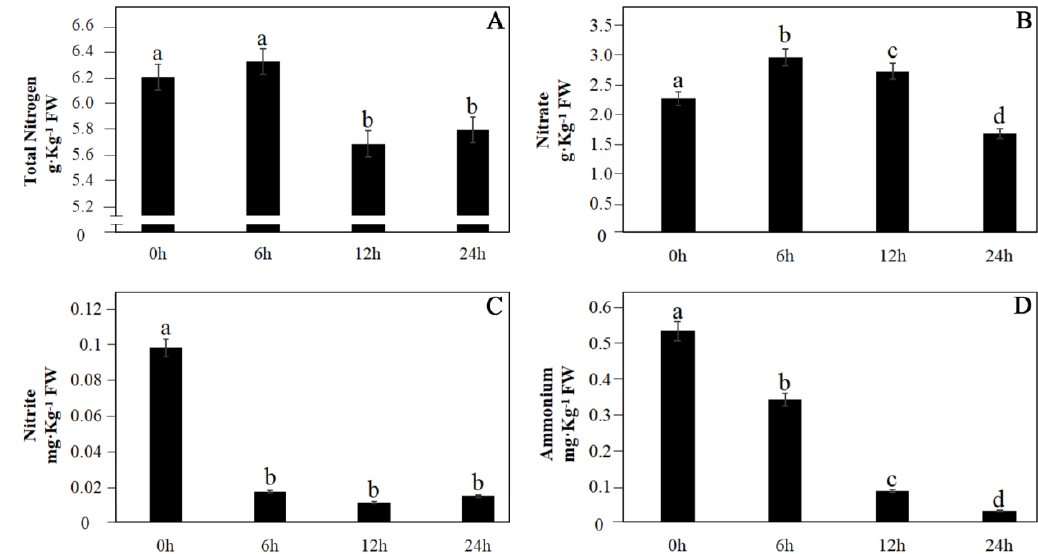
Figure 1. E ff ects of elevated CO 2 on di ff erent nitrogen forms. ( A ) Total nitrogen, ( B ) nitrate, ( C ) nitrite, Figure 1. Effects of elevated CO 2 on different nitrogen forms. ( A ) Total nitrogen, ( B ) nitrate, ( C ) nitrite, ( D ) ammonium. Significant di ff erences ( p < 0.05) are indicated with lowercase letters. FW, fresh weight. ( D ) ammonium. Significant differences ( p < 0.05) are indicated with lowercase letters. FW, fresh weight. Table 2. E ff ect of elevated CO 2 on free amino acids. 0 h 6 h 12